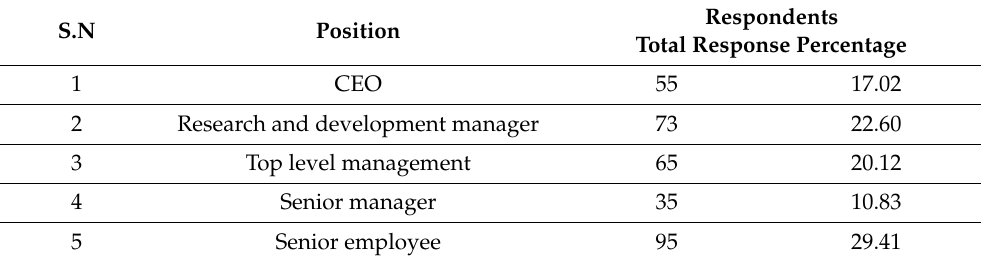
Table 1. Respondents’